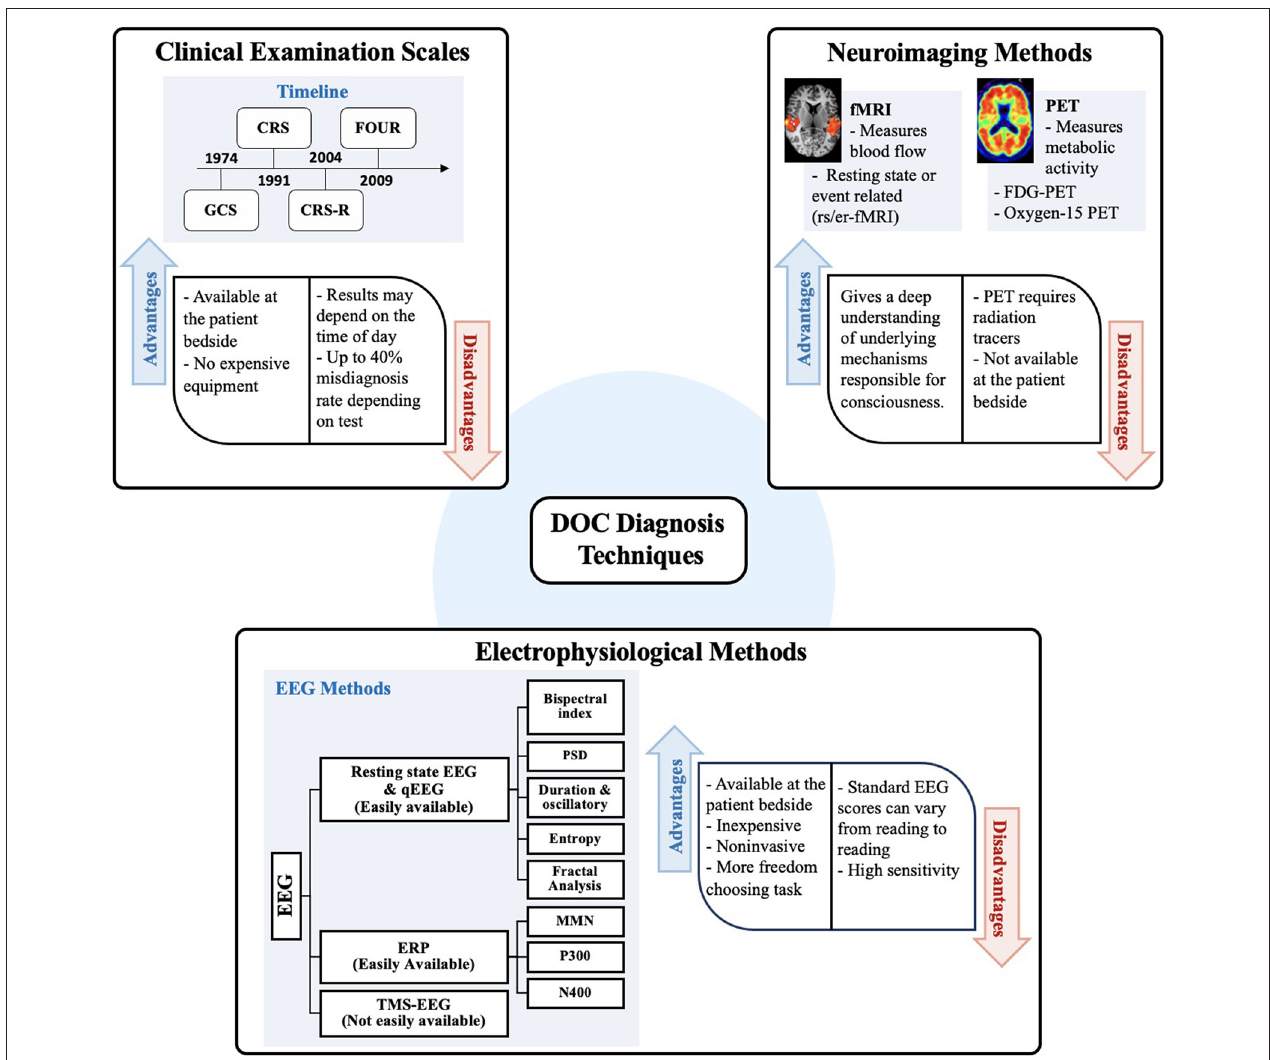
FIGURE 2 | This schematization summarizes the main methods used to distinguish diagnosis between VS/UWS and MCS. Clinical examination scales are illustrated using a timeline indicating implementation or modification of existing scales since 1974. Next, neuroimaging methods commonly used such as PET and fMRI in DOC patients are listed. Finally, electrophysiological methods and different approaches for feature extraction from EEG are listed as well as different tasks implemented by using EEG. Advantages and disadvantages are also summarized for each method. GCS, Glasgow coma scale; CRS, Coma recovery scale; CRS-R, Coma recovery scale-revised; FOUR, Full outline of unresponsiveness; STAR, Sensory tool to assess responsiveness; EEG, electroencephalogram; QEEG, Quantitative analysis of electroencephalogram; ERP, Event-Related potential; MMN, Mismatch negativity; TMS, Transcranial magnetic